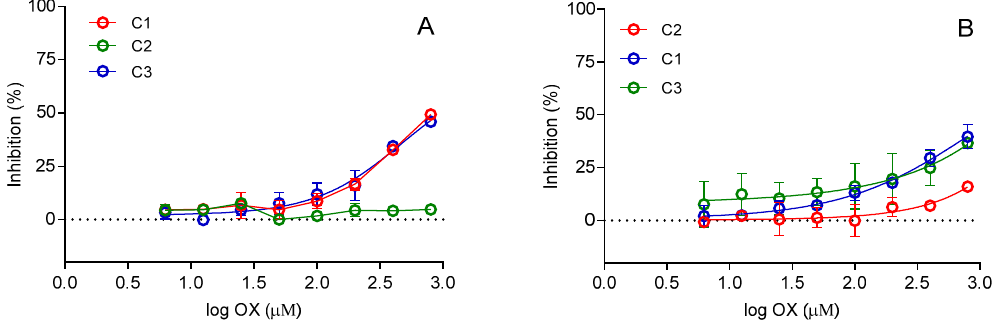
Figure 6. Cytotoxicity of oximes C1, C2, and C3 on two cell lines ( A ) HepG2, human Caucasian hepatocyte carcinoma, epithelial; ( B ) SH-SY5Y human neuroblastoma cell line.